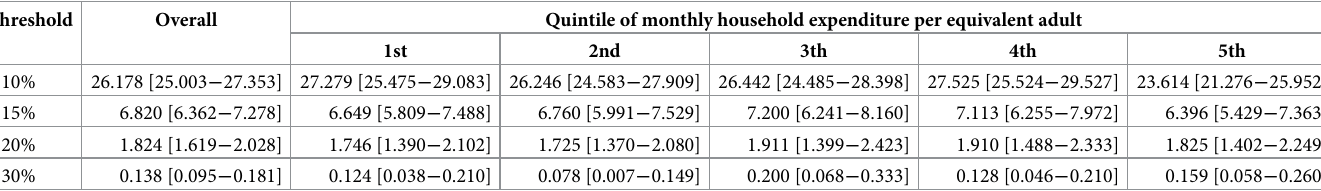
Table 4. Adjusted share of OOPE on medicines out-off total household expenditure according to quintile of household expenditure. HIES, Bangladesh, 2016/17. Threshold Overall Quintile of monthly household expenditure per equivalent adult 1st 2nd 3th 4th